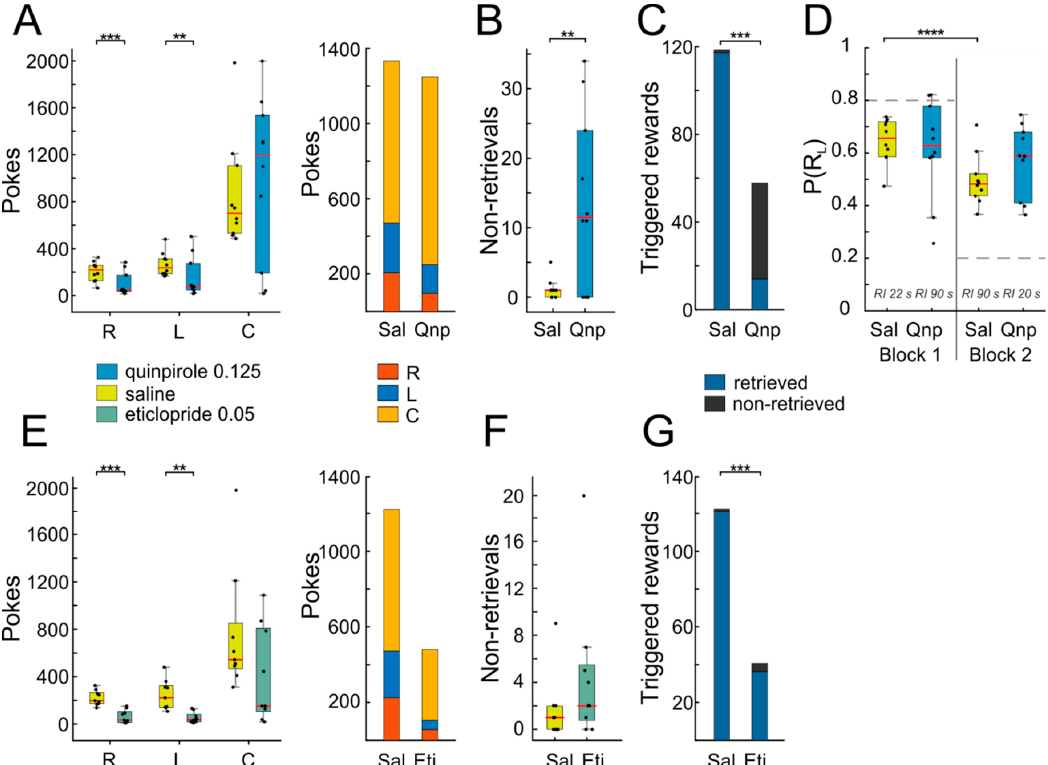
Figure 6. Systemic administration of dopamine D2-receptor compounds alters task performance. ( A ) Left: Quinpirole administration reduced overall responding to both response ports (L and R), but not at the reward port (C). Right: Total number of pokes at the L, R and C ports displayed separately for saline (Sal) and quinpirole (Qnp). ( B ) Quinpirole significantly increased the number of non-retrieved rewards. ( C ) A total number of triggered rewards with those that were retrieved in blue and those that were not retrieved in black. ( D ) P(R L ) before (Block 1) and after (Block 2) mid-session change in the reward schedule, which required the animals to adapt their responses to the reversed reward ratio as in the first half of the session. Animals changed their responses, according to the reinforcement ratio (indicated in the graph) after saline administration, but not after quinpirole administration. Dashed horizontal lines indicate optimal behavior as predicted by the Matching law. ( E – G ) As in A – D , but for behavior after eticlopride vs. vehicle administration. In all box plots, individual data points (black dots) are laid over a box depicting the 25th and 75th percentiles; the horizontal red mark indicates the median, whiskers extend to the most extreme observations, outliers are plotted individually. Asterisks indicate significant differences between drug and vehicle as determined by paired samples t-tests (** ≤ 0.01, *** ≤ 0.001, **** ≤ 0.0001). Not unexpectedly, the effects of eticlopride differed from those of quinpirole. While eticlopride also led to a drastic reduction in operant responding (Figure 6E, n = 9, right port: T(8) = 4.87, p = 0.001; left port: T(8) = 3.8, p = 0.005), in turn resulting in low numbers of triggered rewards (Figure